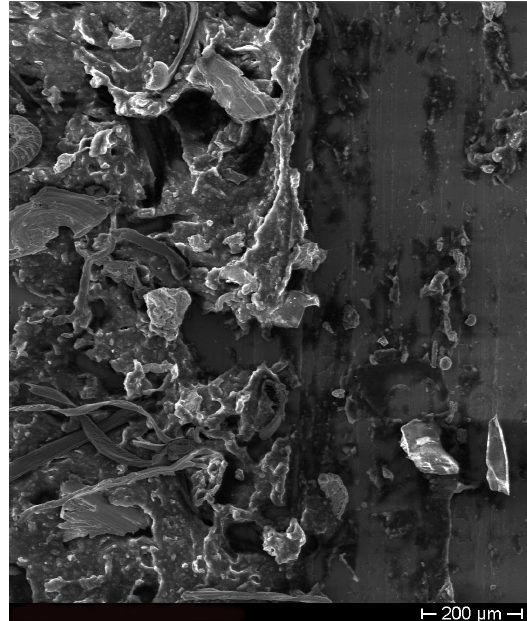
Figure 13: SEM micrograph of metallic debries inside a grease patch found in the internal surface of the nipple.